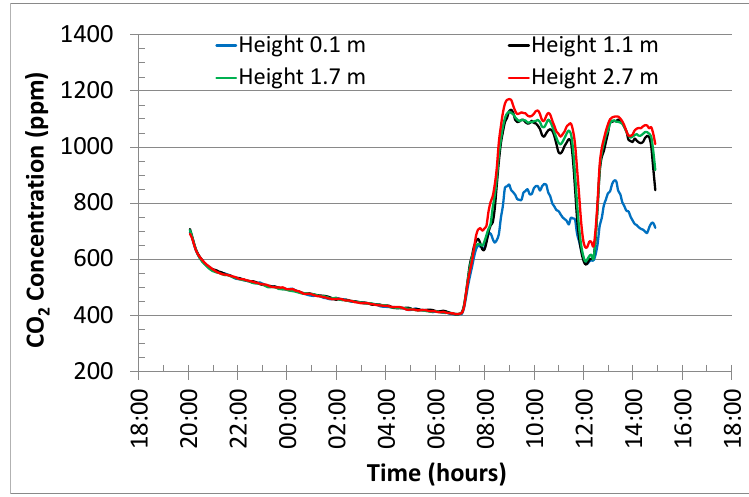
Figure 17. Measured vertical CO 2 concentrations for the field experiment.